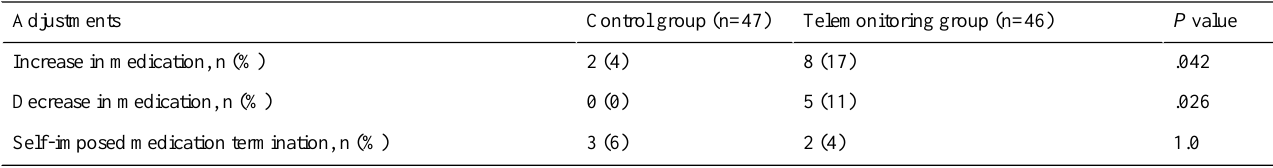
Table 3. Categorized medication adjustments and the number of patients to whom the adjustments were